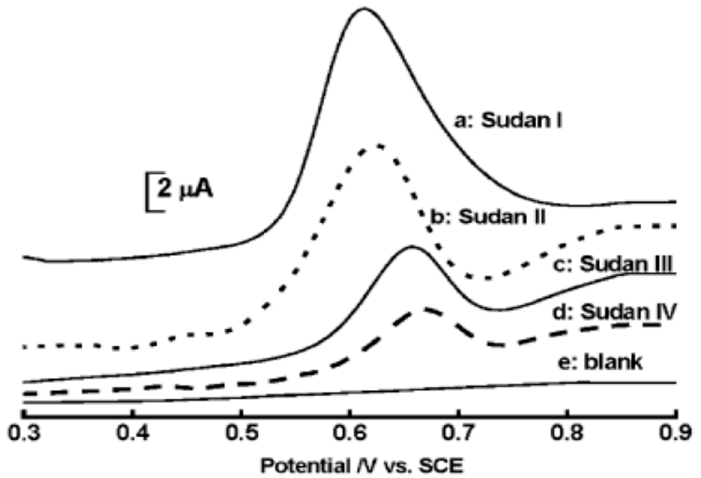
Figure 18. Square-wave voltammetric responses of 0.3 mg L − 1 Sudan dyes at the MMT-Ca modified CPE after 2 min accumulation time. (a) Sudan I; (b) Sudan II; (c) Sudan III; (d) Sudan IV; and (e) blank voltammograms. Reprinted with the permission of Reference [51]. [License Number 5067500862861]. Table 10. Table showing Sudan detection using carbon paste electrodes with different modifiers along with their detection limits.